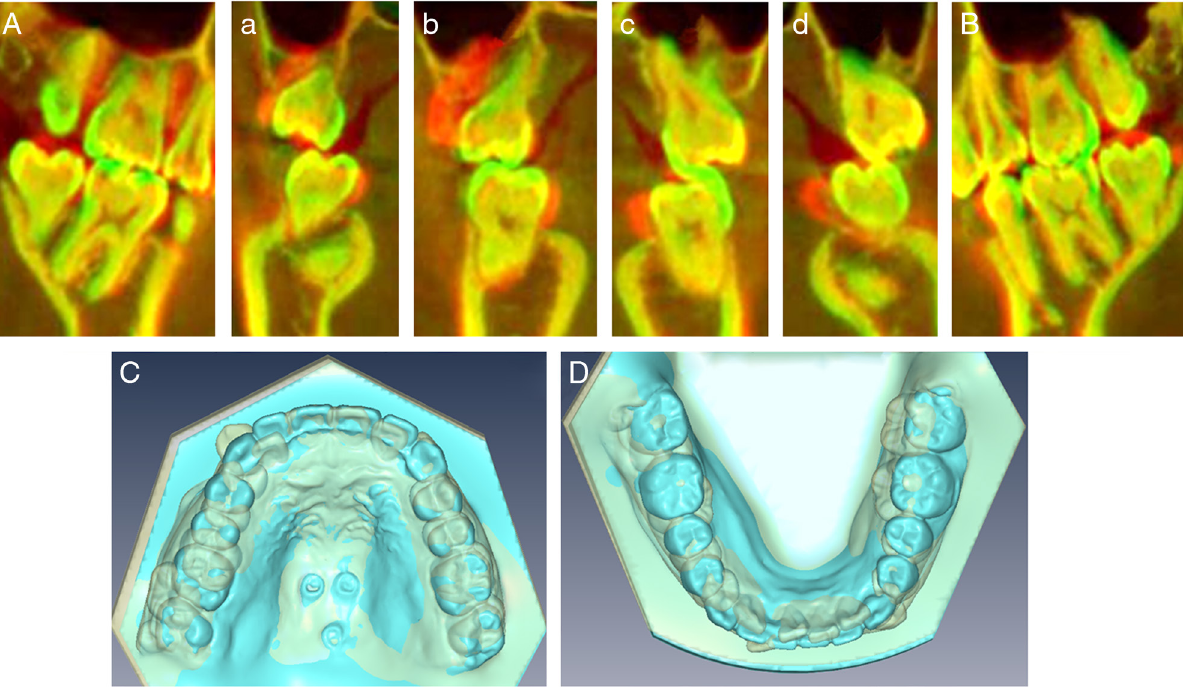
Figure 6. Superimposition. Cone-beam computed tomography (CBCT) images at pre-treatment (red) and post-treatment (green): (A) Sagittal and coronal views of the right side (a, first molars; b, second molars); (B) Sagittal and coronal views of the left side (c, first molars; b, second molars). Dental casts at pre-treatment (yellow) and post-treatment (blue): (C) Maxilla; (D) Mandible.